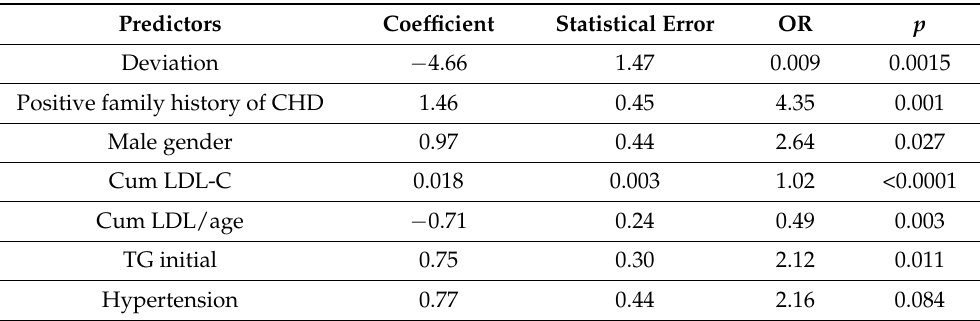
Table 3. Statistical significance of coefficients in calculating the odds ratio of IHD in FH patients (logistic regression analysis).